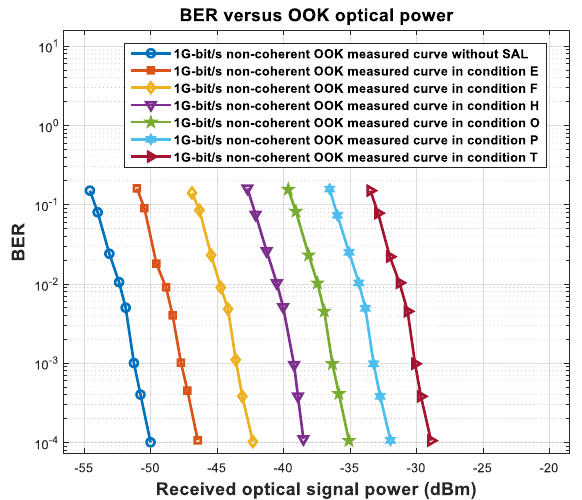
Figure 15. BER vs. non-coherent OOK optical power in different conditions.